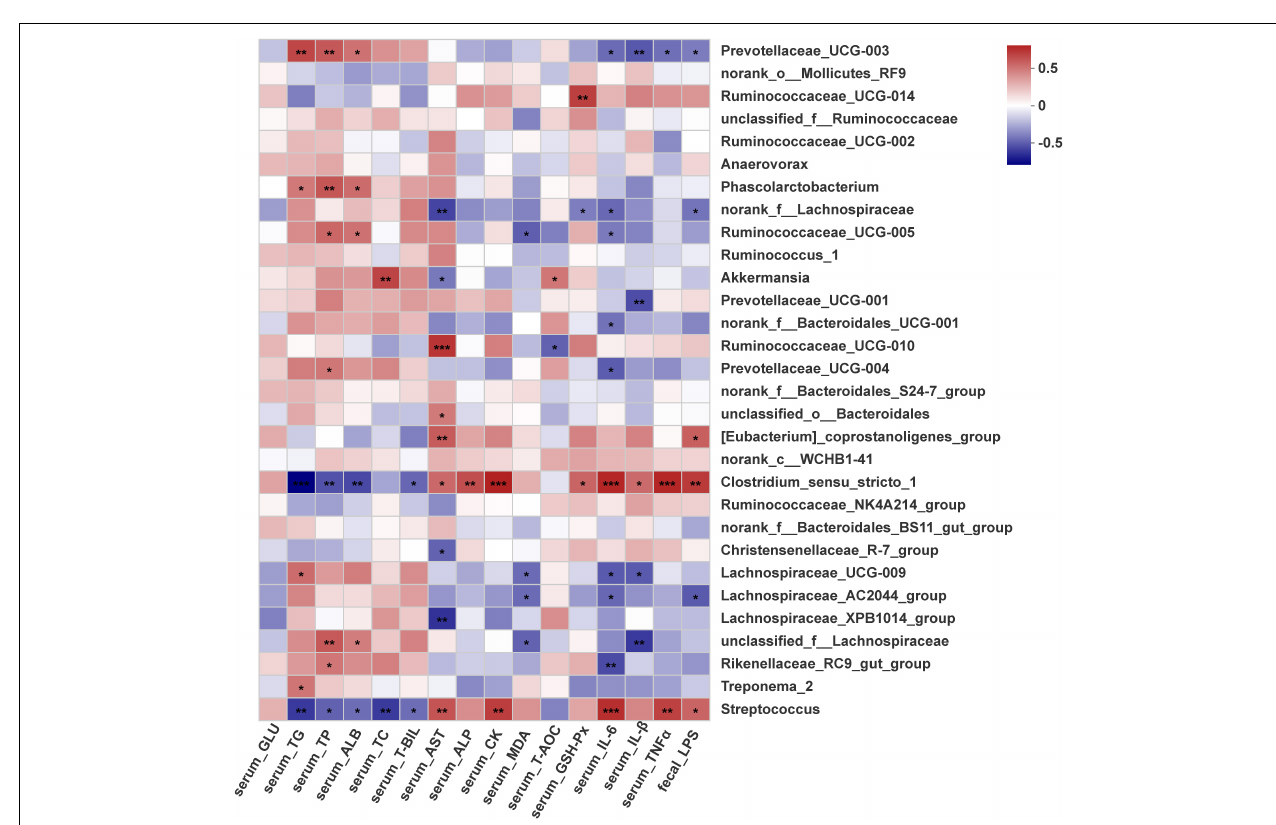
FIGURE 6 | Correlation plot showing Spearman’s correlations among serum metabolism, oxidative status and inflammation, fecal LPS and core genera (top 30). * p < 0.05, ** p < 0.01, *** p <